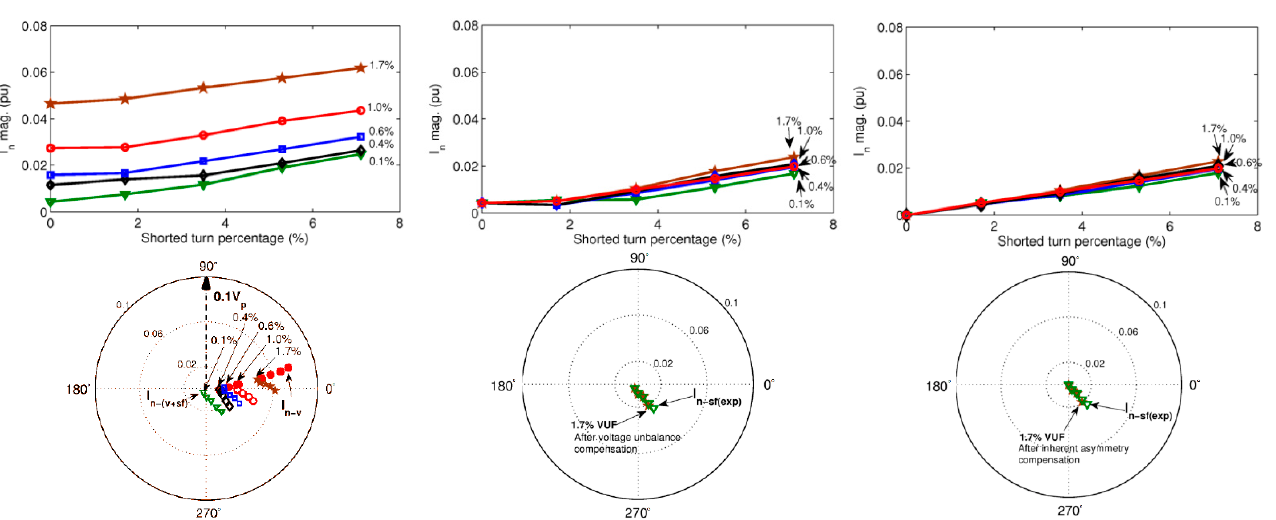
( f ) Figure 15. The test results at various shorted turn fault levels of 0% (triangle), 1.7% (diamond), 3.5% (square), 5.3% (circle) and 7.1% (star), before inherent asymmetry elimination of the magnitude of I n ( a ), phasor diagram of I n ( d ), after inherent asymmetry elimination of the magnitude of I n ( b ), phasor diagram of I n ( e ), and the corresponding voltage unbalance factors and ( c ) the negative sequence impedances ( f ). Figure 15c,f show the percentage of voltage unbalance and the negative sequence impedance as a function of the motor load. As can be observed in the figures, the effect of the negative sequence current magnitude decreases slightly with increasing load (Figure 15a). This is caused by the negative sequence impedance (Figure 15f) that increases slightly with the load. However, the negative sequence voltage remains relatively constant, as illustrated in Figure 15c.